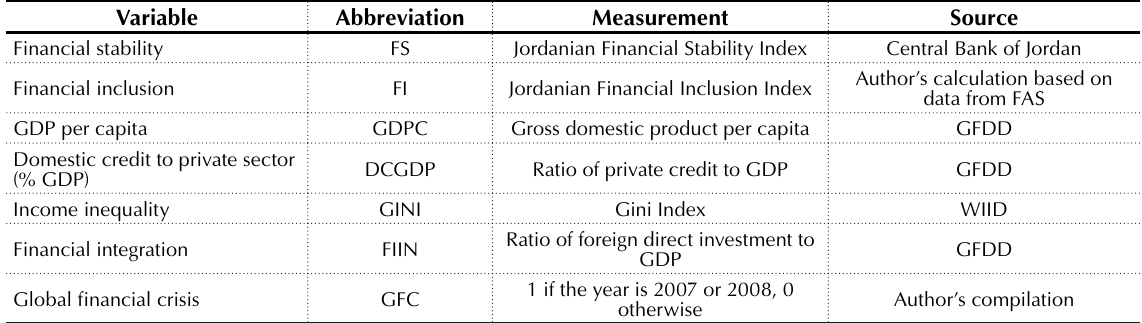
Table 2. Variables of the